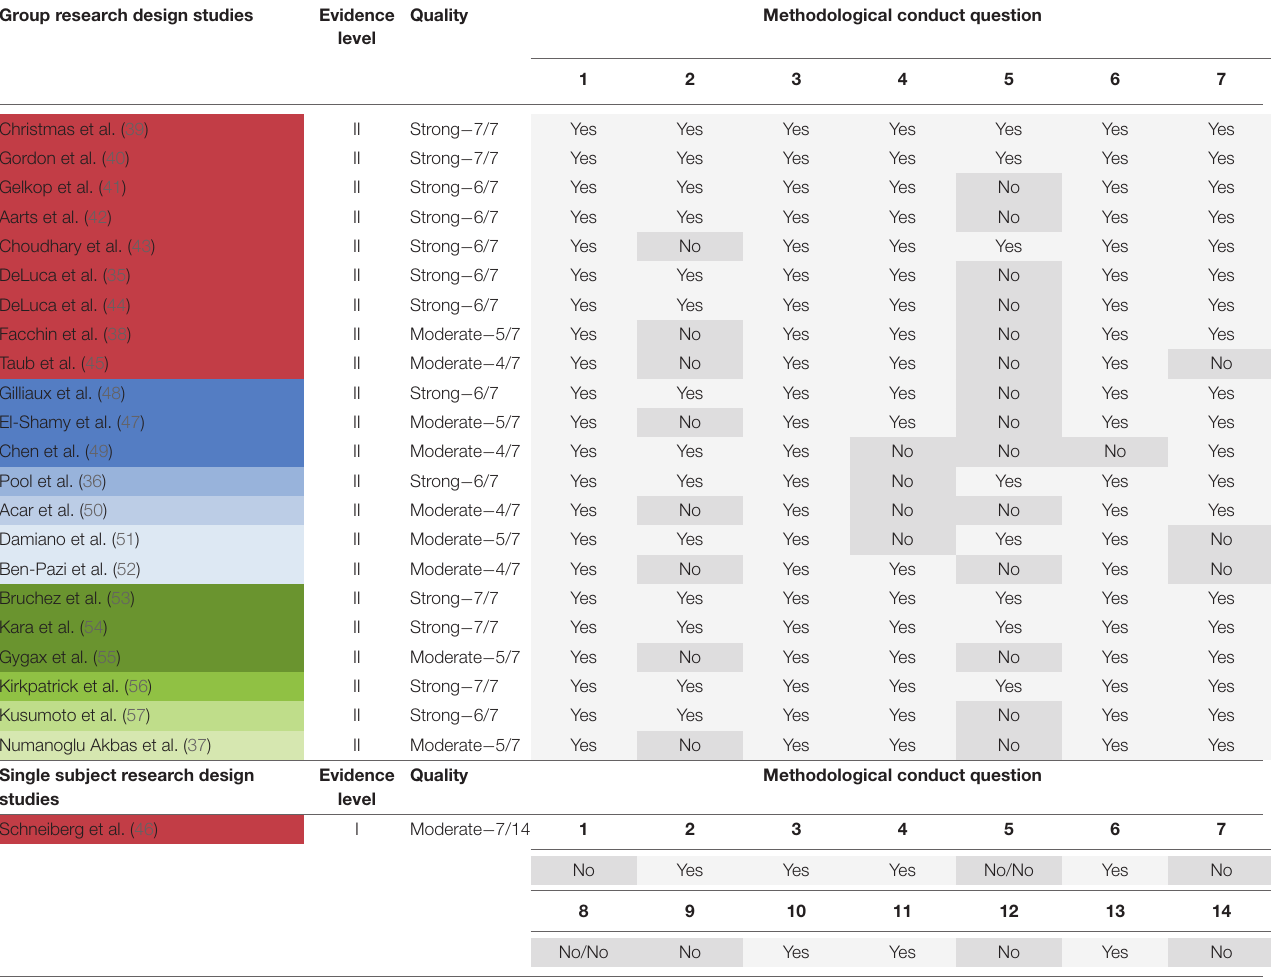
TABLE 3 | Levels of evidence and methodological quality rating of included studies in accordance with AACPDM